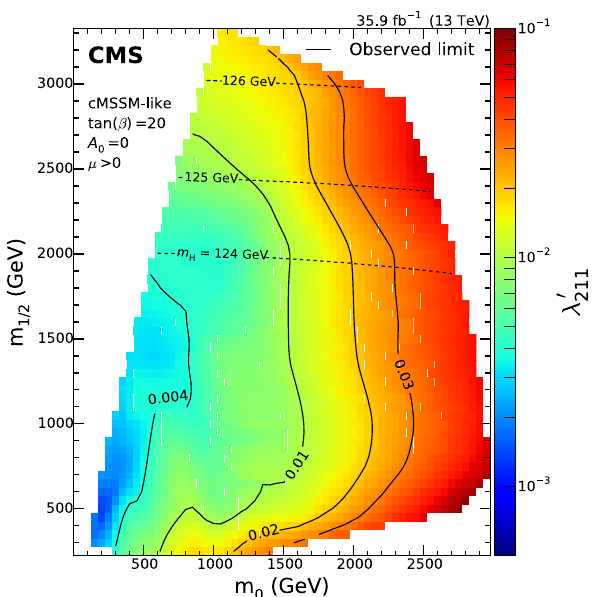
Fig. 5 Upper limits at 95% CL on the coupling λ (cid:3) of m 0 and m 1 / 2 for a modified cMSSM with λ (cid:3) coupling. The color scale at the right side of the figure indicates the coupling limit value for specific parameter combinations. These limits are derived from the upper cross section limits of SM1. For four values of λ (cid:3) (0.004, 0.01, 0.02, 0.03), the coupling limits are shown as black 211 contour lines. The dashed lines show the parameters in the model that correspond to the mass of the lightest Higgs boson for three chosen values (124, 125,